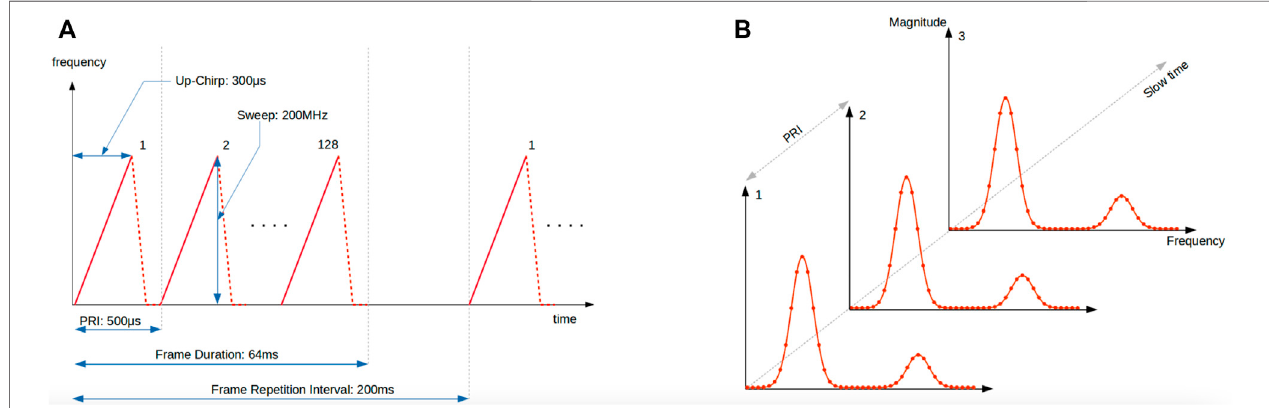
FIGURE 3 | Firmware Con fi guration (A) . Hypothetical magnitude of the complex samples in the matrix F along each column, in the case of two scatterers (B) .